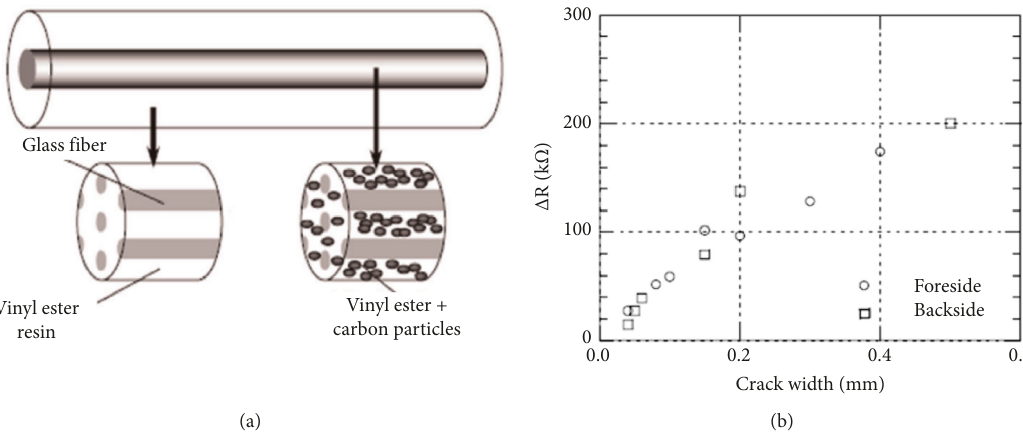
Figure 15: (a) Intelligent response to fiberglass [81]. (b) The resistance of intelligent fiberglass concrete varies with the crack width [81].